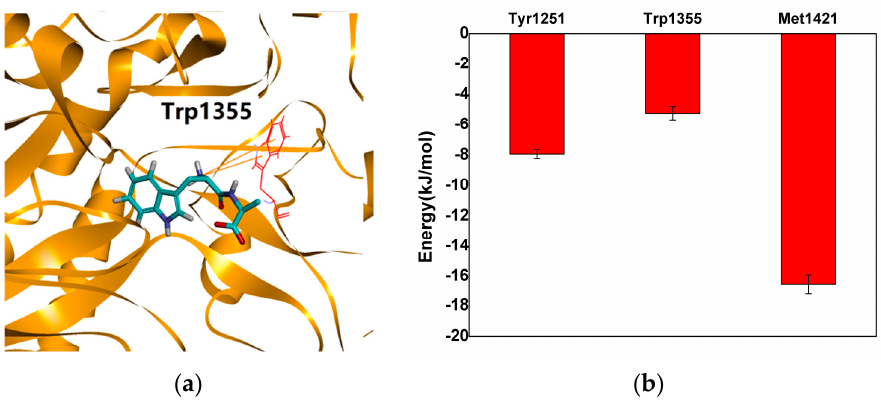
Figure 8. ( a ) The cation ‐π interaction of cluster 1 from MGAM ‐ WA and ( b ) the energy contributions of the vital residues of cluster 1 from MGAM ‐ WA.